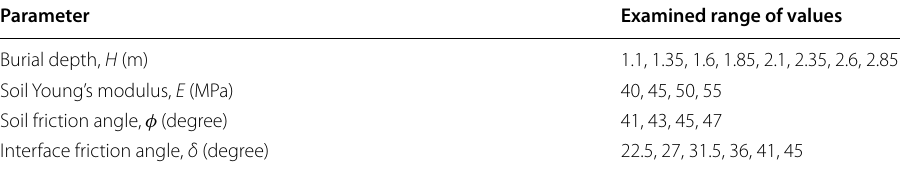
Table 4 Different soil and pipe parameters used in the parametric study Parameter Examined range of values Burial depth, H